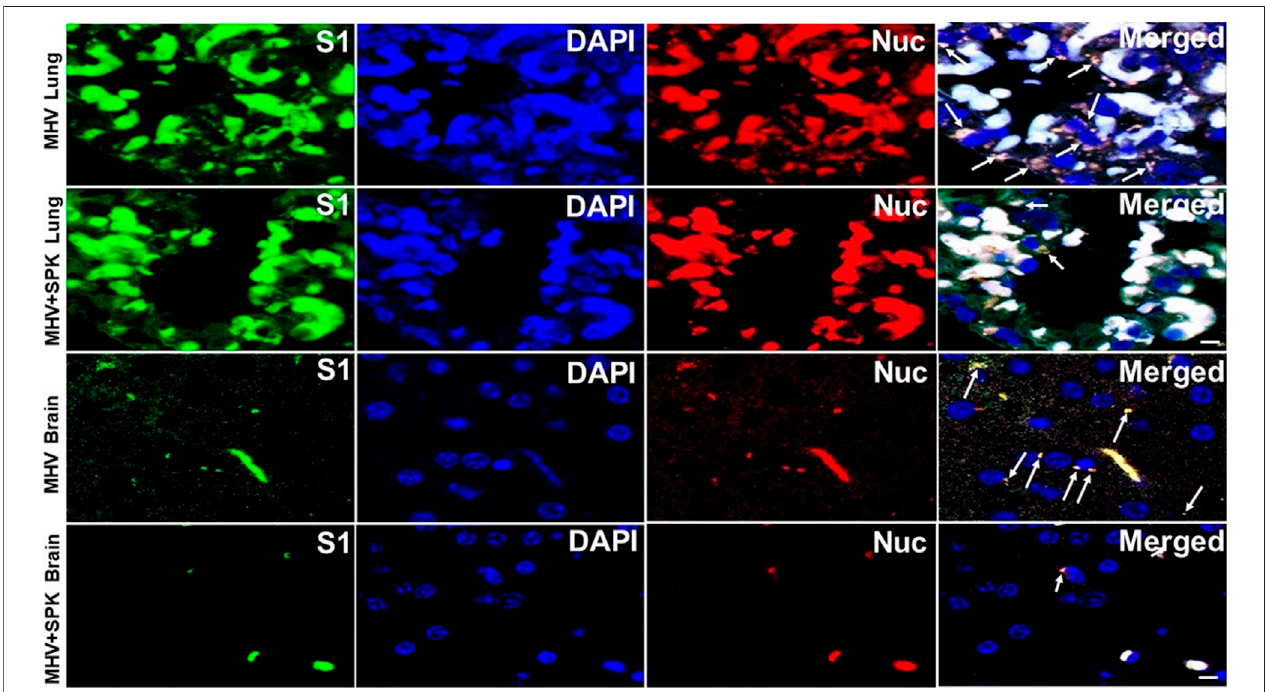
FIGURE 8 | The presence of MHV-1 virus with and without SPK treatment in lung and brain. The long arrows indicate the presence of viral particles (S1 and Nucleocapsid)inthelungsandbrainsofMHV-1infectedmice.TheshortarrowsindicatethereducedlevelofviralparticlesinSPKtreatedgroup n =4.Scalebar=30 μ m.